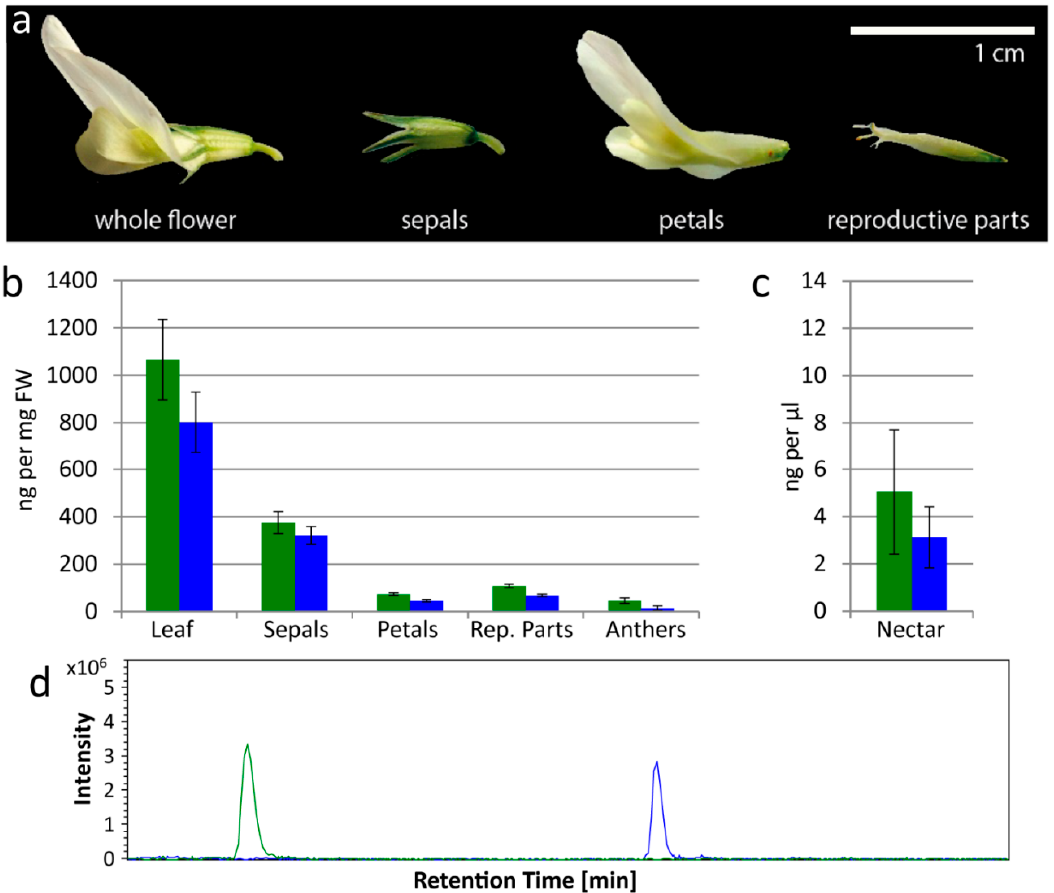
Figure 1. Cyanogenic glucosides are found by LC-MS in leaves, flowers and nectar of white clover. ( a ) A single Trifolium repens flower, separated into sepals, petals and reproductive parts (stamens and pistils combined). ( b ) Linamarin (green) and lotaustralin (blue) concentrations (determined by LC-MS) in leaves and flower parts (sepals, petals, combined reproductive parts, anthers) of T. repens ; four samples for each. ( c ) Linamarin (green) and lotaustralin (blue) concentrations (determined by LC-MS) in nectar of T. repens ; four samples. Error bars in b-c show standard error. ( d ) Representative Extracted Ion Chromatogram (EIC) from LC-MS showing linamarin (green, [M + Na] + = 270) and lotaustralin (blue, [M + Na] + = 284) in nectar.